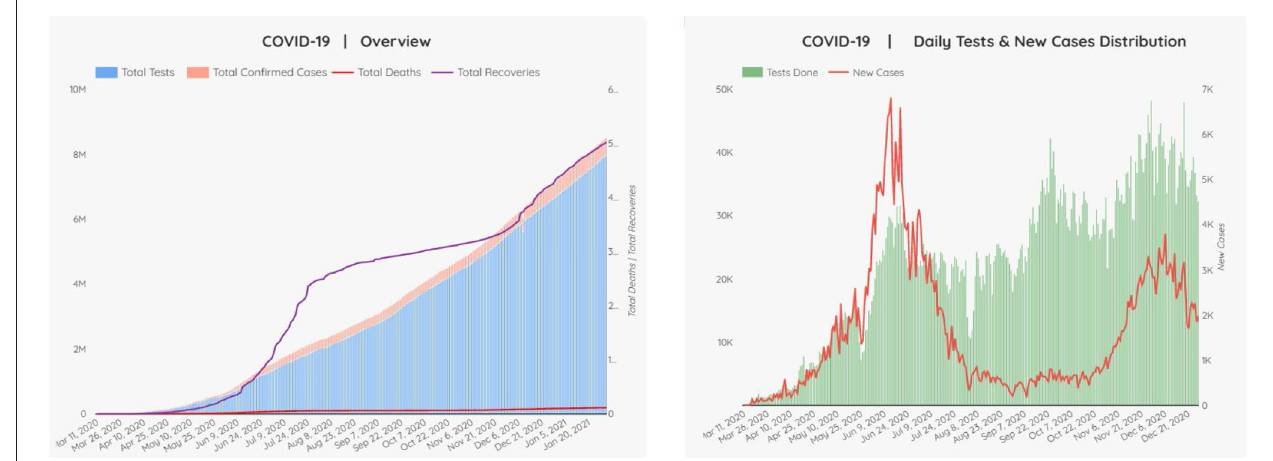
FIGURE 4 | COVID-19 across Pakistan - February 12, 2021. Source: Ministry of Health, Pakistan.